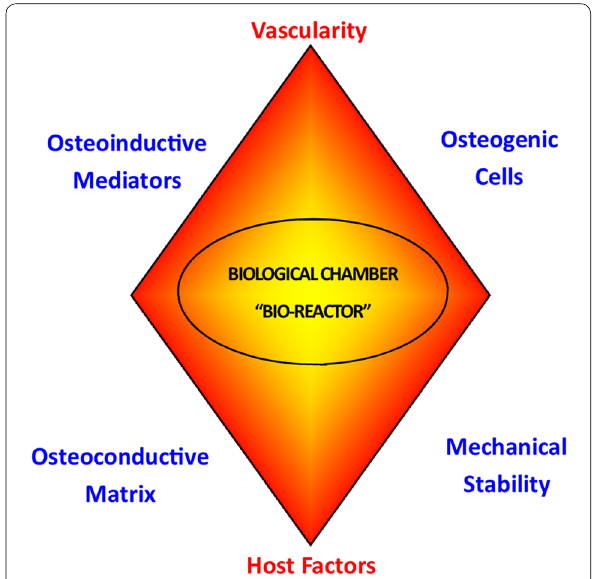
Fig. 1 Illustration of the ‘diamond concept’ of bone healing